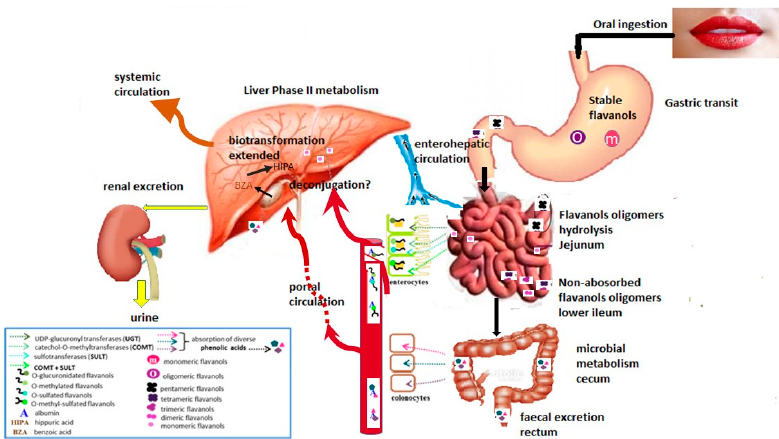
Figure 1. Cocoa flavanols bioavailability. Depolymerization of cocoa procyanidins in the stomach is negligible after ingestion of cacao-derived food products. Thus, most of them reach the small intestine unchanged. Once in the upper intestine, the flavanol monomers and oligomers undergo extensive metabolism (mainly phase II reactions: catechol-o-methytransferase (COMT), sulfotransferase (SULT) and uridine 5 diphosphate glucuronilsyltransferase (UGT)) within the enterocyte (jejunum) that gives rise to a range of O-methylated, O-glucuronidated, and O-sulfated flavanol derivatives. After absorption, the conjugated metabolites are bound to albumin and transported to the liver via the portal vein. Inside the hepatocytes, cocoa flavanols experience extended phase II biotransformations. The resulting metabolites can take 3 different pathways: reach other tissues through systemic circulation or get back to the duodenum procyanidins that are not absorbed in the small intestine can be metabolized by colonic microflora (lower